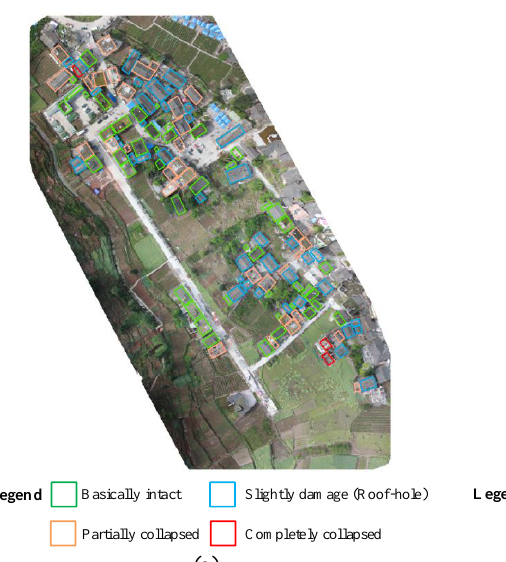
Figure 9. Results of building damage classification in two study areas: (a) results of building damage in Yuxi village; (b) results of building damage in Zhoujiawan